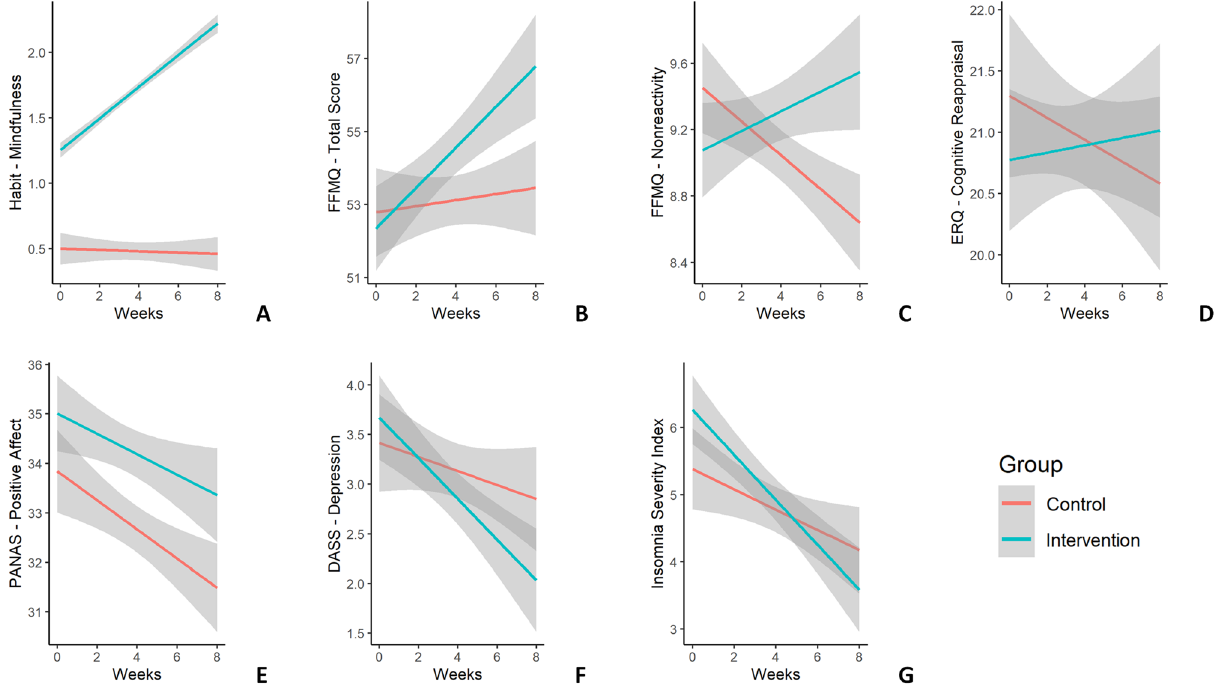
Figure 1. Time course of predicted average scores for different well-being and stress indices in longitudinal analyses. The x-axis in the plots represents the weeks of the intervention (from 0—before intervention—to 8— final week) and the y-axis represents participants’ scores. The red line represents the control group (N = 63), while the green line represents the intervention group (N = 69). The grey shaded area represents 95% confidence intervals. The y-axis represents predicted average scores for ( A ) the habit “Please specify how much time you spent doing the following activity: Practicing mindfulness (or other forms of meditation)”. See Supplementary Materials for further details on the questionnaire. ( B ) the mindfulness variable (FFMQ-15 questionnaire) total score and ( C ) the FFMQ-15 nonreactivity subscale, ( D ) the cognitive reappraisal variable (ERQ questionnaire), ( E ) the positive affect variable (PANAS questionnaire), ( F ) the depression variable (DASS-21 questionnaire), ( G ) the insomnia score (ISI